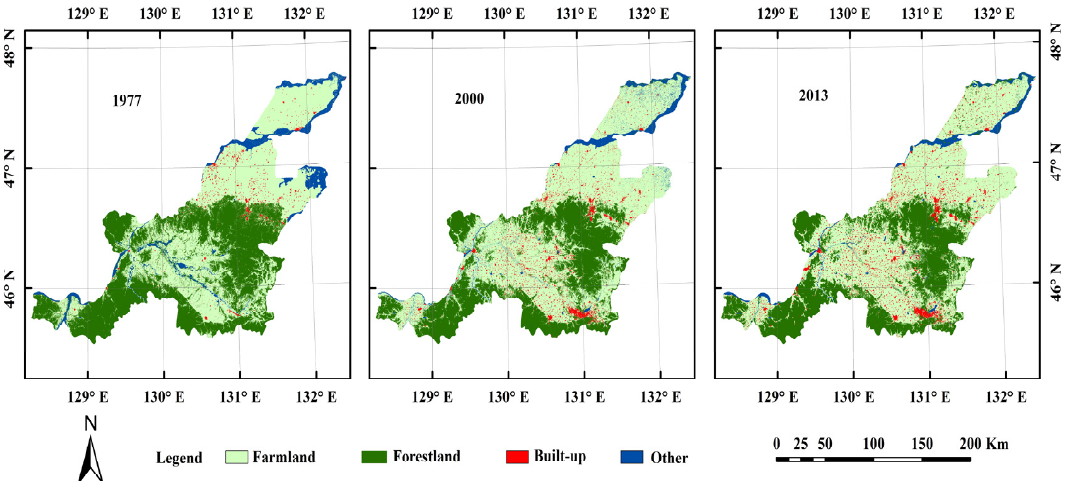
Figure 2. Classified land use and land cover change maps of the study region in 1977, 2000, and 2013.